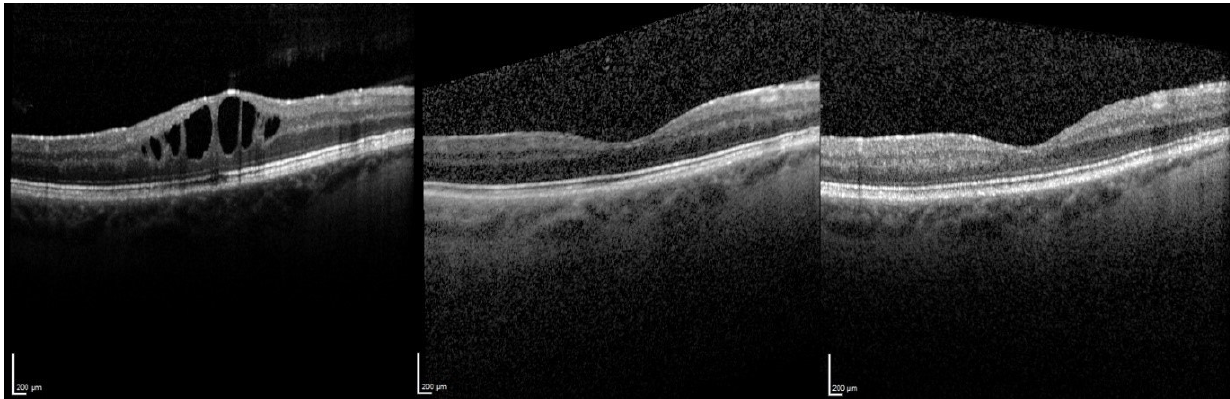
Figure 3. Optical coherence tomography pre FAc, 3 months post FAc and 60 months post FAc injection.